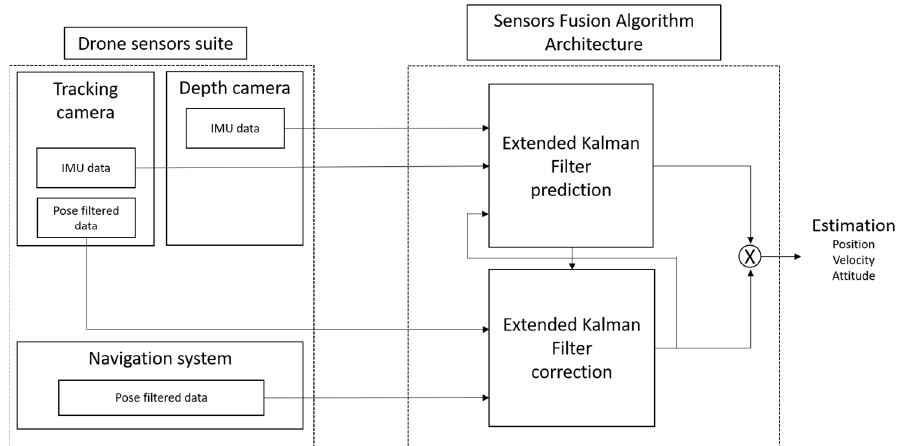
Figure 4. Sensor fusion algorithm architecture.